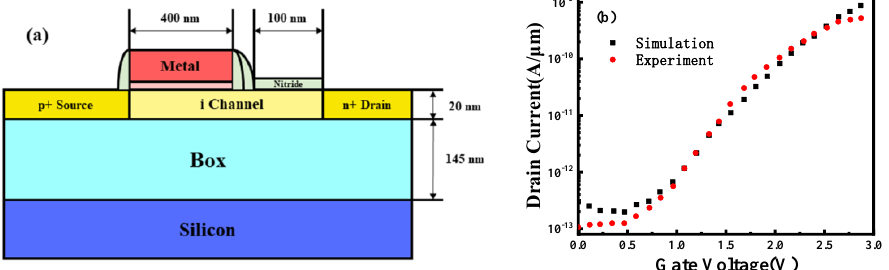
Figure 3. ( a ) Schematic of SOI TFET cell. ( b ) Comparison of simulated and experimental transfer characteristics results for SOI TFET.